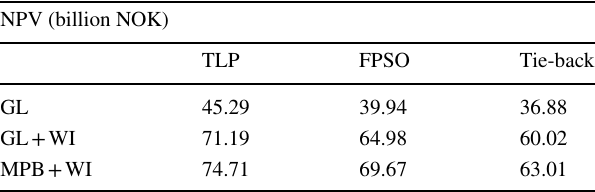
Table 3 Maximum NPV obtained for each development